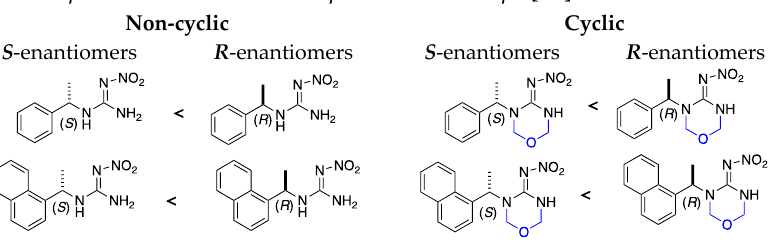
Figure 6. Absolute configuration – activity relationship (ACAR) of chiral nitroguanidines.